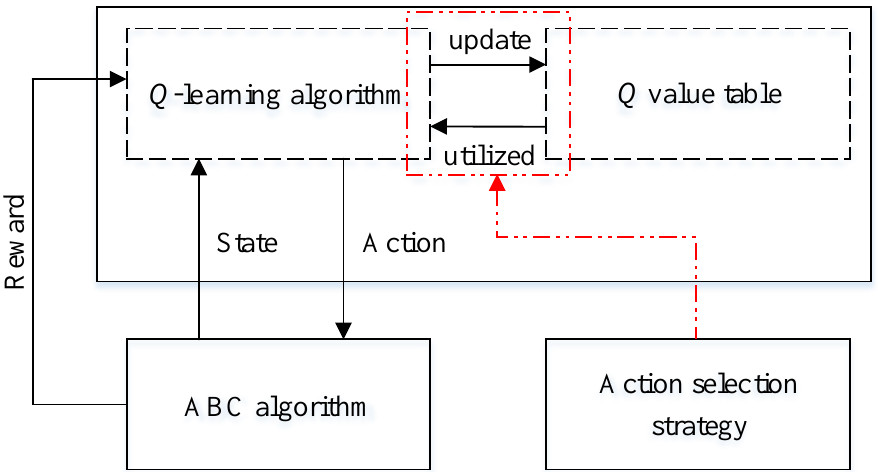
Figure 7. The combination model of ABC and Q -learning.